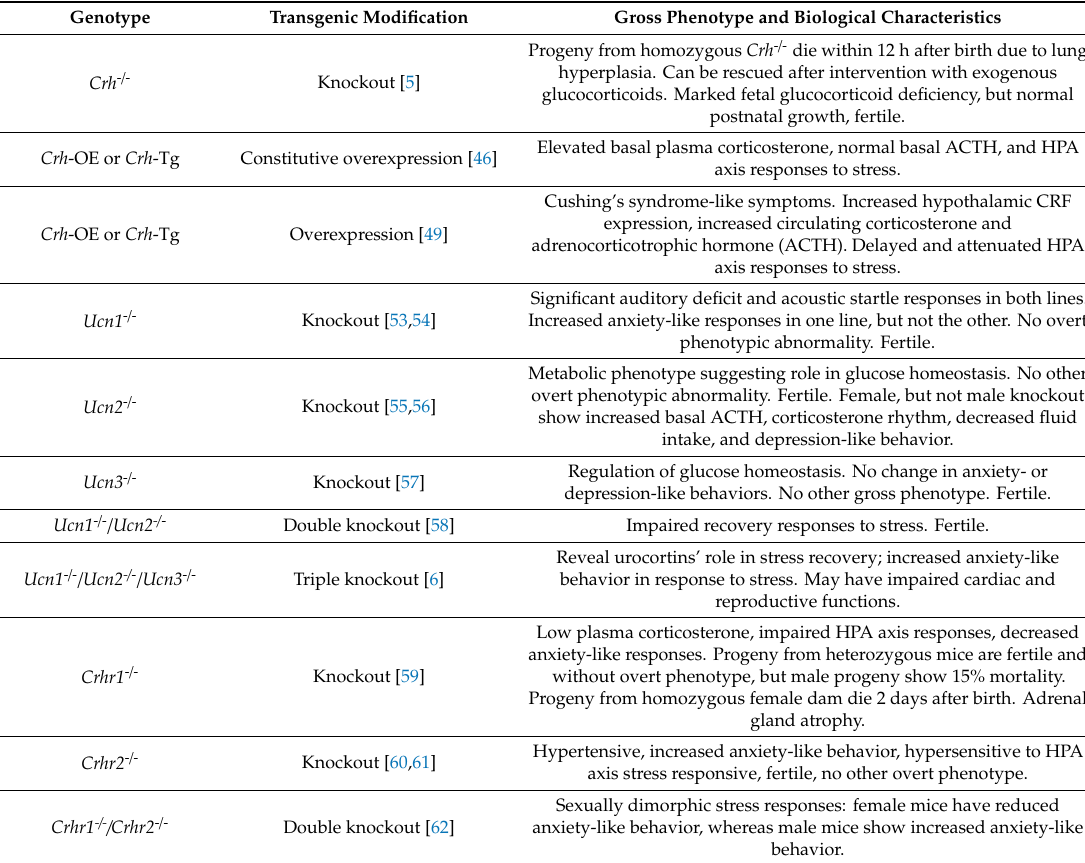
Table 1. Phenotypic characteristics of transgenic modifications in genes for components of the CRF family of peptide hormones and